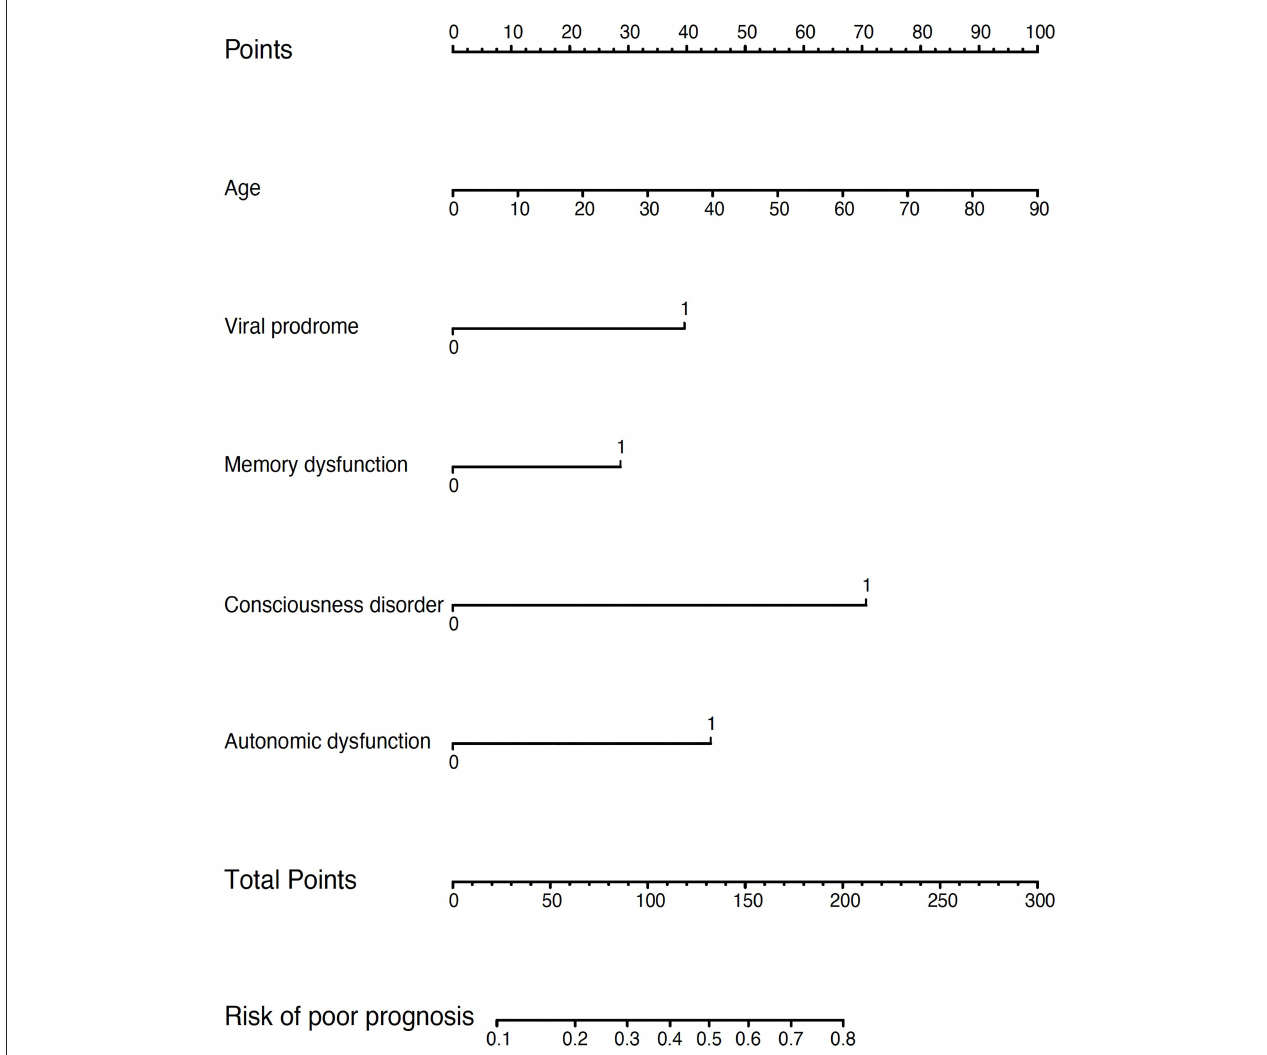
FIGURE 3 | Nomogram to estimate the probability of poor prognosis in AE. A nomogram for poor prognosis prediction was developed and integrated with the predictors. Find the predictor points on the upper most point score that correspond to each patient variable and sum them. The total points projected to the bottom score indicate the percentage of probability of poor prognosis. For example, a 20-year-old male patient with memory dysfunction, consciousness impairment, autonomic dysfunction and no viral prodrome would have a score of 162.5 (22.5 + 27.5 + 70 + 42.5), corresponding to an 65% probability of poor prognosis.